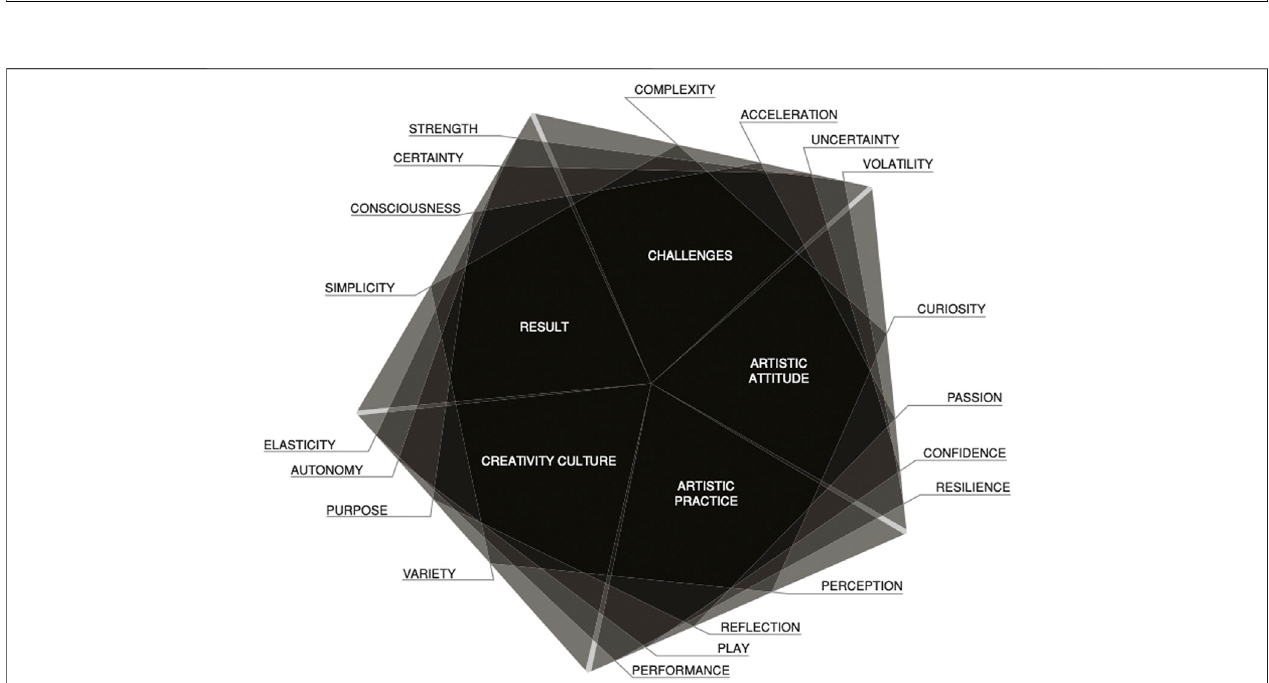
FIGURE 2 | Age of artists, bloom (used with permission) (Dobiéy and Koeplin, 2020).